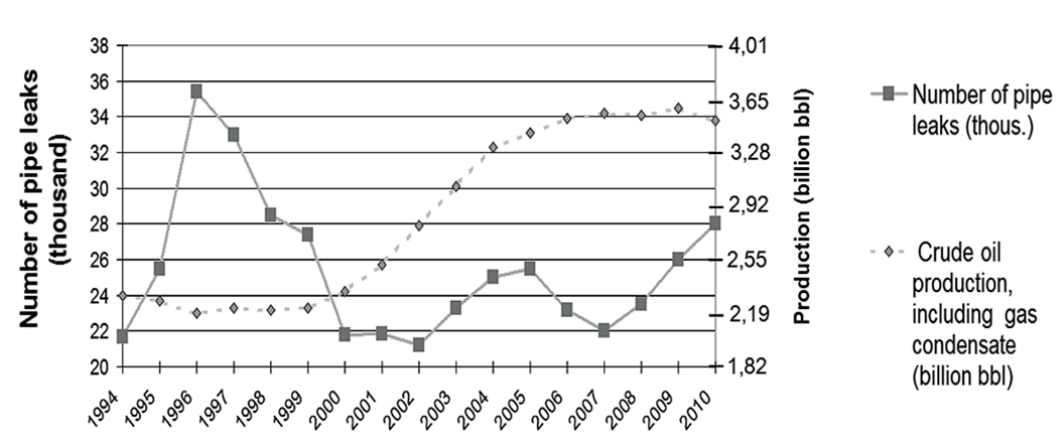
Fig. 1 Crude oil production and number of pipe leaks in Russia (Blokov